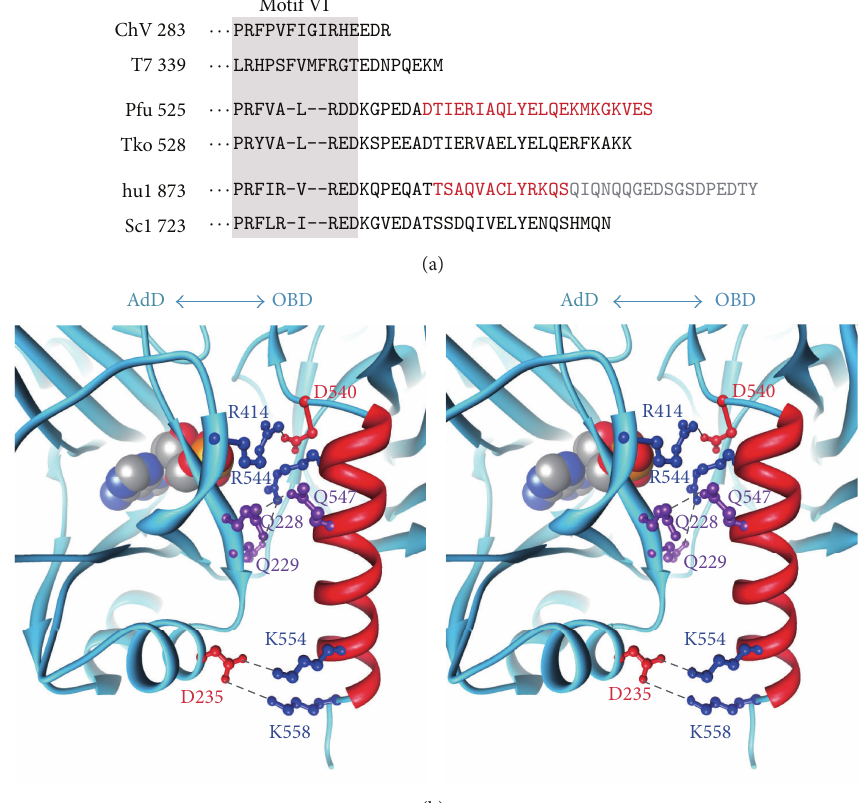
Figure 13: Roles of the C-terminal extension helix. (a) Alignment of the sequences of motif VI and the C-terminal extension. The sequences of the DNA ligases from a virus (ChV, Chlorella virus), bacteriophage (T7, bacteriophage T7), Archaea (Pfu, Pyrococcus furiosus ; Tko, Thermococcus kodakaraensis ), human (hu1, human DNA ligase I), and yeast (Sc1, Saccharomyces cerevisiae DNA ligase I) are aligned. The region for motif VI is shaded, and the extension helix region, determined by the crystal structures of PfuLig and hLigI, is colored red (residues after Q902 of hLigI were not included in the previously reported crystal structure and are colored gray). (b) Stereo diagram of the interface of the AdD and the OBD in PfuLig. Ball-and-stick models represent the amino acid residues involved in the interaction between the two domains: basic, acidic, and polar residues are colored blue, red, and purple, respectively. The C-terminal helix is colored red. The dotted lines indicate the polar or ionic interactions between AdD and